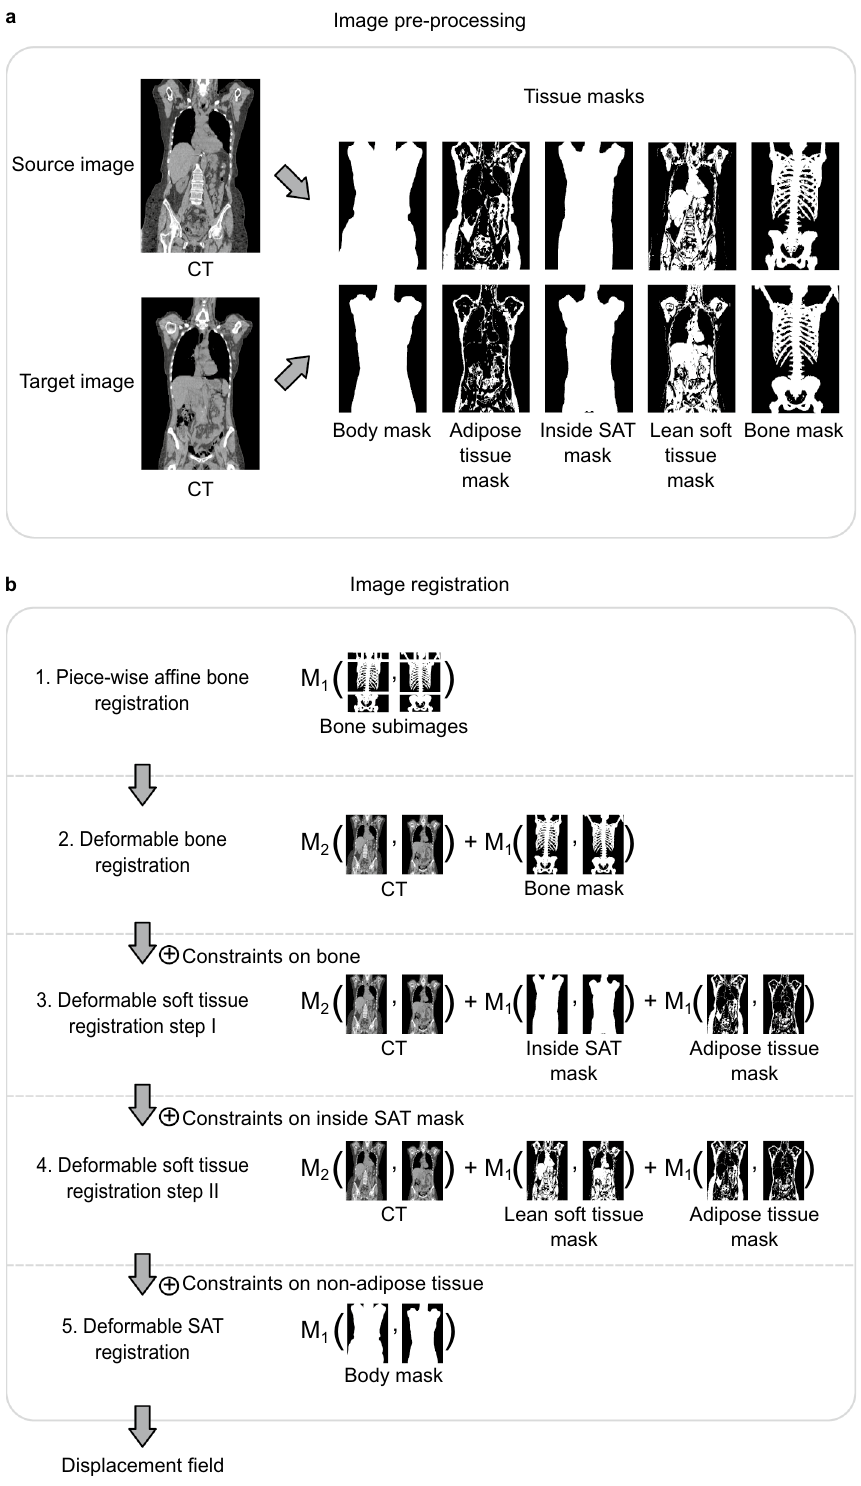
Figure 1. Image pre-processing ( a ) and registration steps ( b ). Image registration of one source image to one target image is illustrated. In ( a ), tissue masks are generated from both source and target image. In ( b ), these masks, are in addition to the original CT images, used to spatially align the images step-by-step. Image input, similarity metrics, and cost function used in each registration step is shown to the right. M1 metric 1 (sum of squared differences), M2 metric 2 (Pearson’s correlation coefficient), SAT subcutaneous adipose